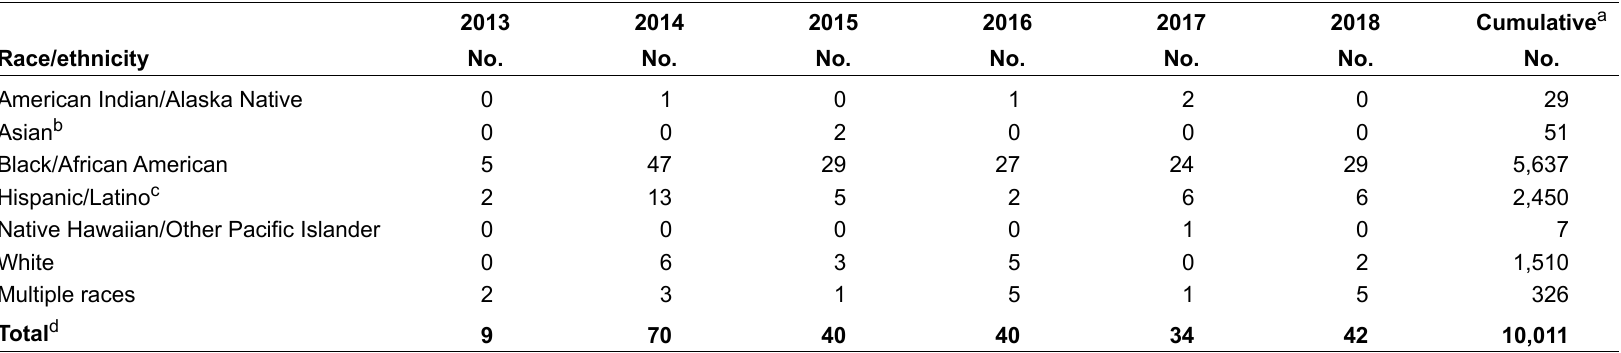
Table 14b. Stage 3 (AIDS) among children aged <13 years, by race/ethnicity, 2013–2018 and cumulative—United States and 6 dependent